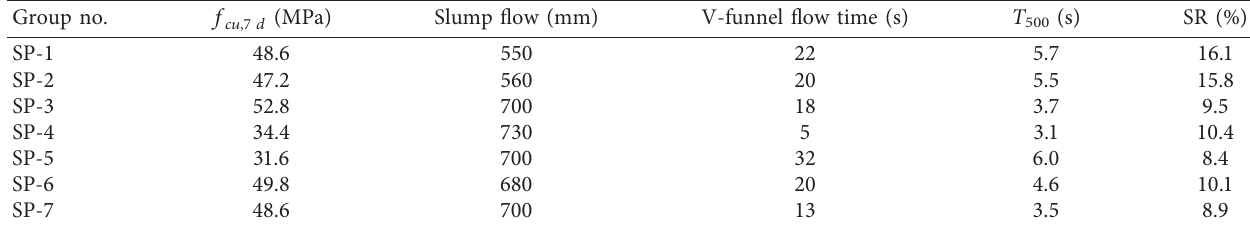
Table 6: Results of trial mix design.